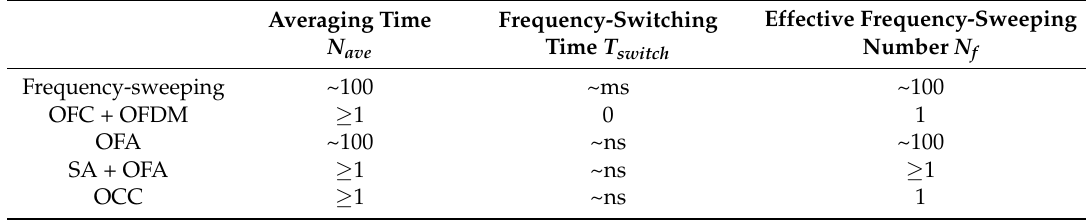
Table 2. Comparison of the proposed BOTDA schemes in this work.